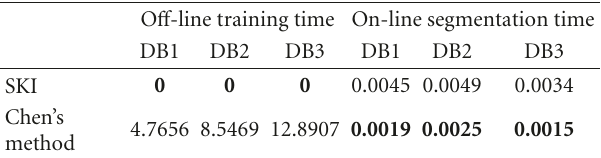
Table 5: Average o ff -line training time and on-line segmentation time (in seconds) of SKI and Chen’s method.